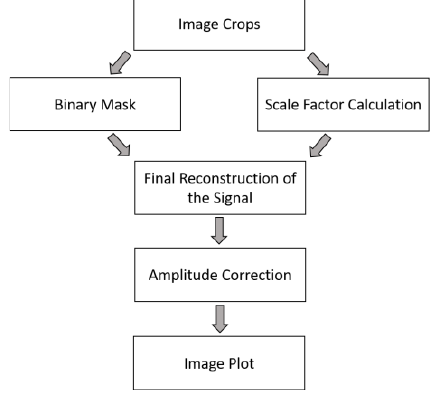
Figure 3. Automatic algorithm pipeline.